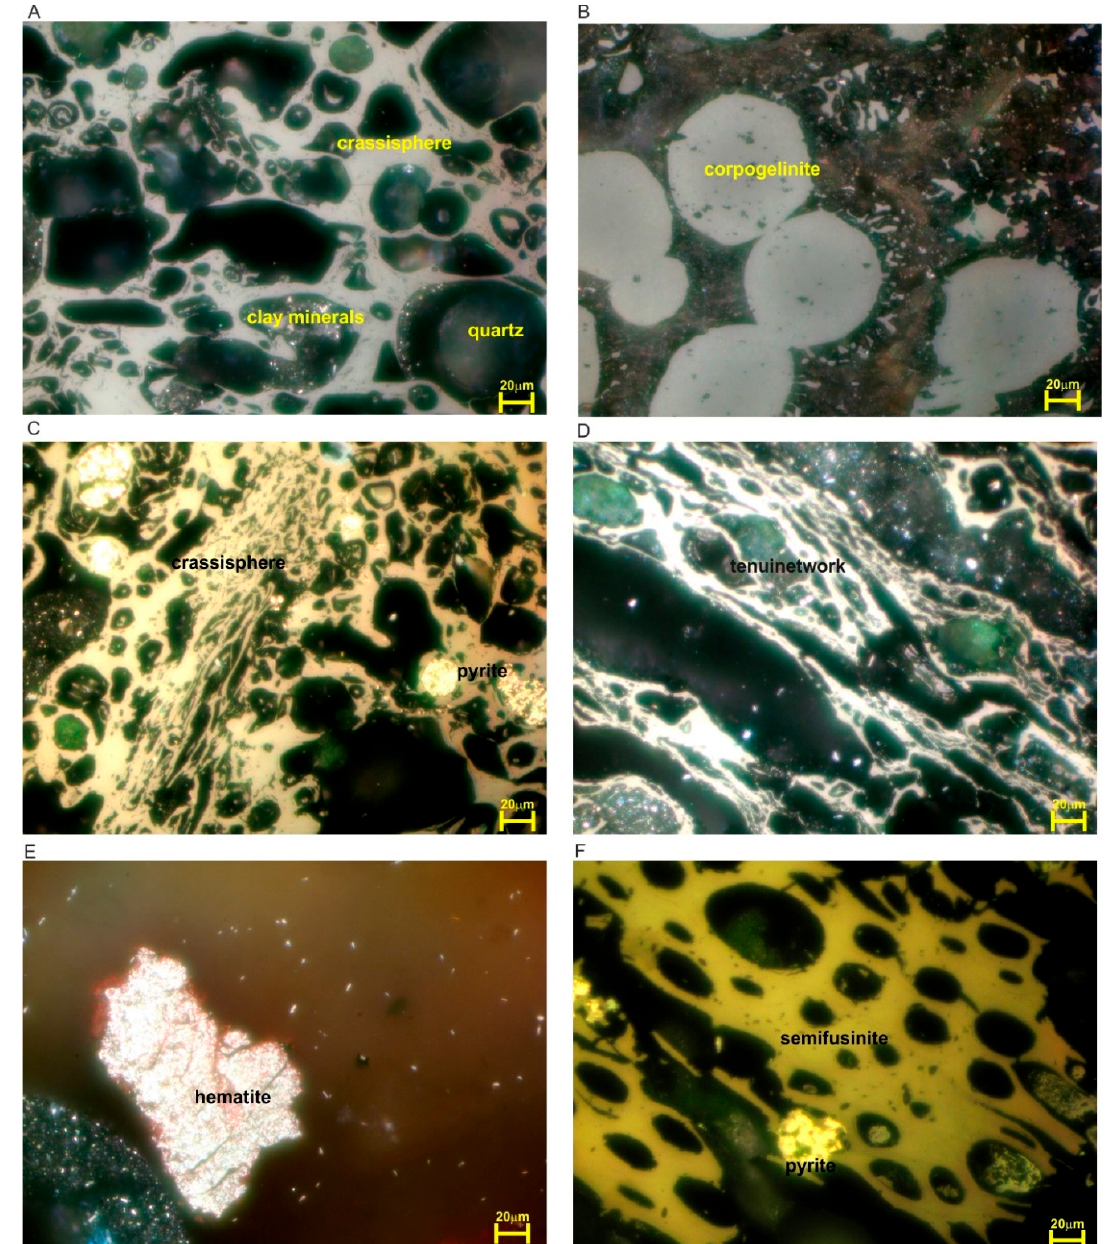
Figure 7. Microscopic image of bottom ash from the combustion of coal from the Janina deposit: ( A ) Quartz and clay minerals in crassisphere pores, ( B ) corpogelinite-like in a mixture of fine organic particles and argillaceous matter, ( C ) bright pyrite in crassisphere pores, ( D ) tenuinetwork, ( E ) hematite, ( F ) semifusinite-like with bright pyrite. Reflected light, oil immersion.